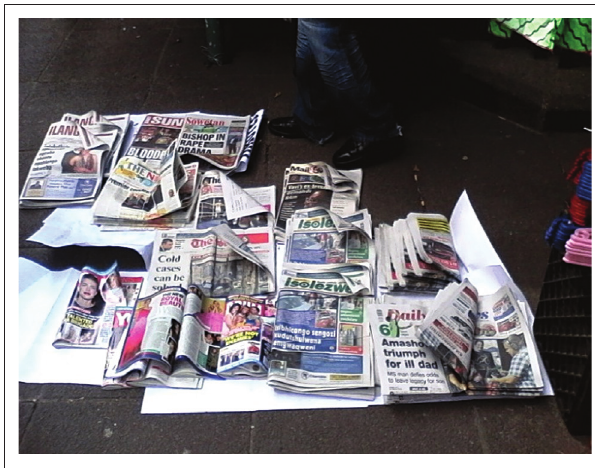
FIGURE 4: Newspaper selling site on a windy